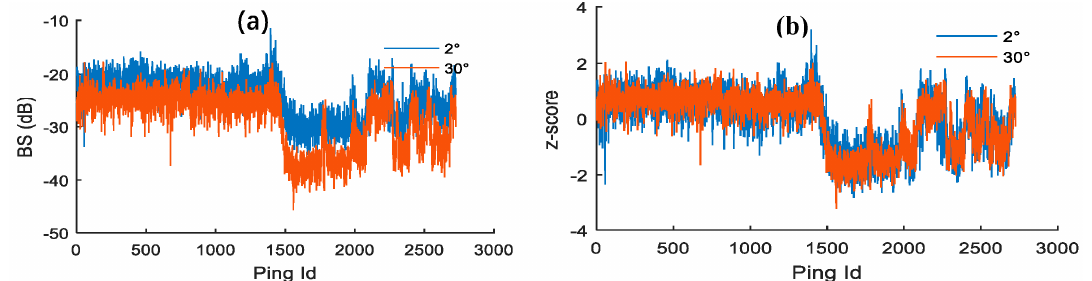
Figure 3. Normalization of MBES BS data. ( a ) Along-track BS sequences at incident angles 2° and 30° and ( b ) corresponding z -score sequences.